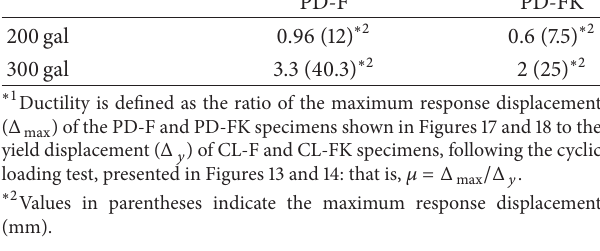
Figure 17: Comparisons between response displacement-time his- tory relationships of the PDF and PD-FK specimens during pseudo- dynamic tests for 200 gal.